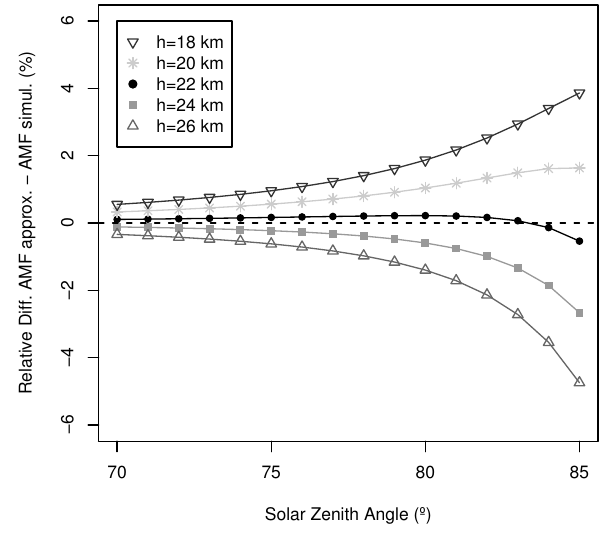
Fig. 2. The monthly mean evolution of the ozone layer altitude (Eq. 6) above Madrid (Spain), considering data between 1995 and 2008. The error bars correspond to ± two standard deviation.